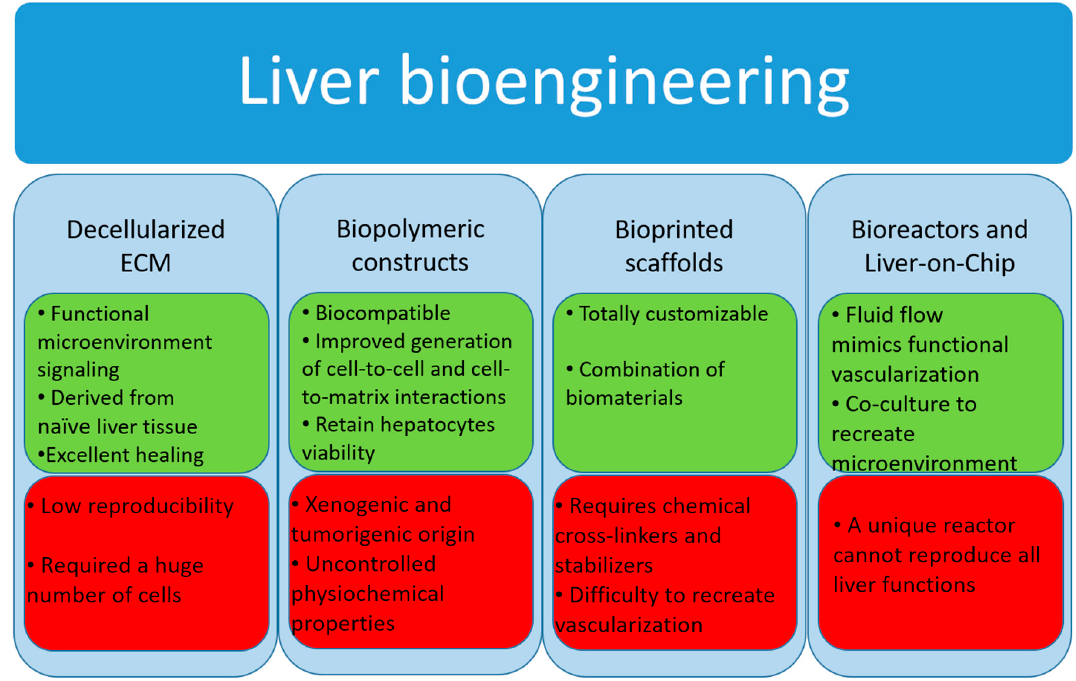
Figure 3. Main pros (green boxes) and cons (red boxes) of the principal liver bioengineering approaches. ECM: extracellular matrix.